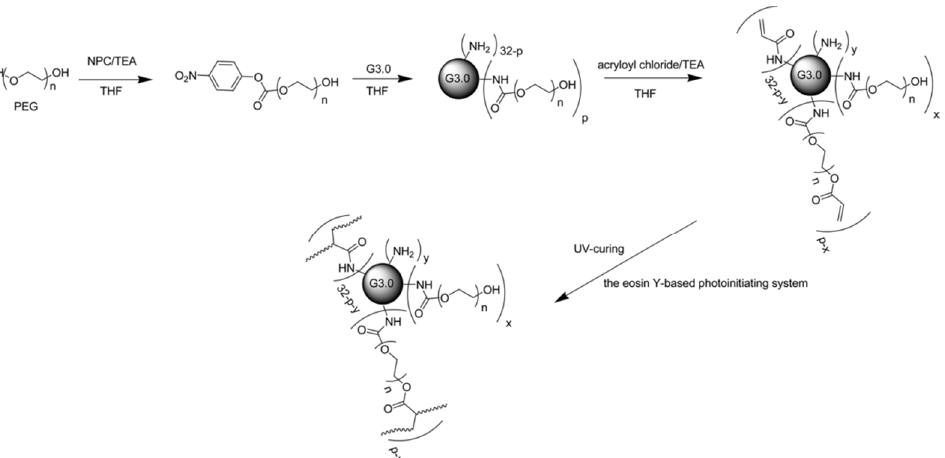
Figure 21. Synthesis of the photoreactive poly(amido amine) (PAMAM) dendron PEG conjugate and photoinitiated crosslinking for hydrogel formation. Reprinted with permission from [49], Copyright © 2010 American Chemical Society.